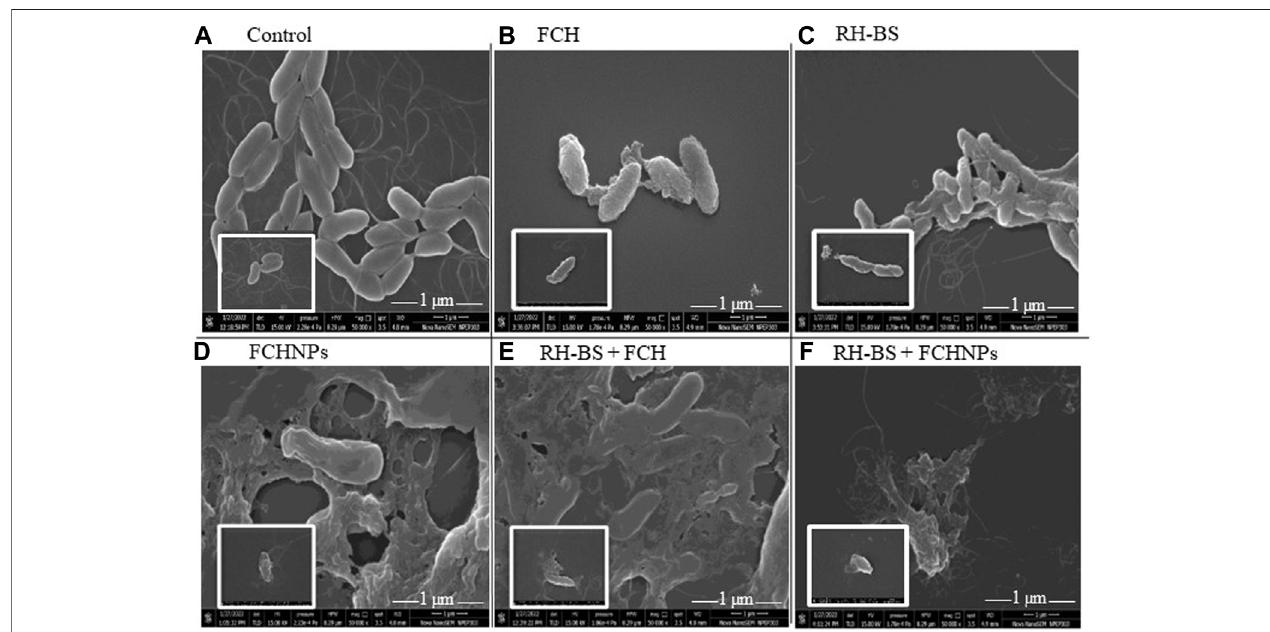
FIGURE5| Scanningelectronmicroscopyimages(×50,000)demonstratingtheeffectofthreetestcompoundsindividually(FCH,RH-BS,andFCHNPs)andintwo combinations (RH-BS + FCH and RH-BS + FCHNPs) at MIC (treated for 24 h and incubated at 30 ° C) on cellular morphology of the bacterial pathogen Xanthomonas campestris NCIM 5028. (A) Control — intact morphology of the untreated cells. (B) Alteration in the cell morphology of pathogen when treated with FCH at MIC ( > 1,024 μ g/ml). (C) Alteration inthe cellmorphology ofpathogen when treatedwith RH-BS at MIC (256 μ g/ml). (D) Rupturedappearance ofthecells ofthe pathogen when treatedwithFCHNPsatMIC( > 1,024 μ g/ml). (E) RupturedappearanceofthecellsofthepathogenwhentreatedwithRH-BS(128 μ g/ml)andFCH(256 μ g/ml)atMIC. (F) Complete distortion of cells of the pathogen due to RH-BS (128 μ g/ml) and FCHNPs at lower MIC (4 μ g/ml) in comparison to